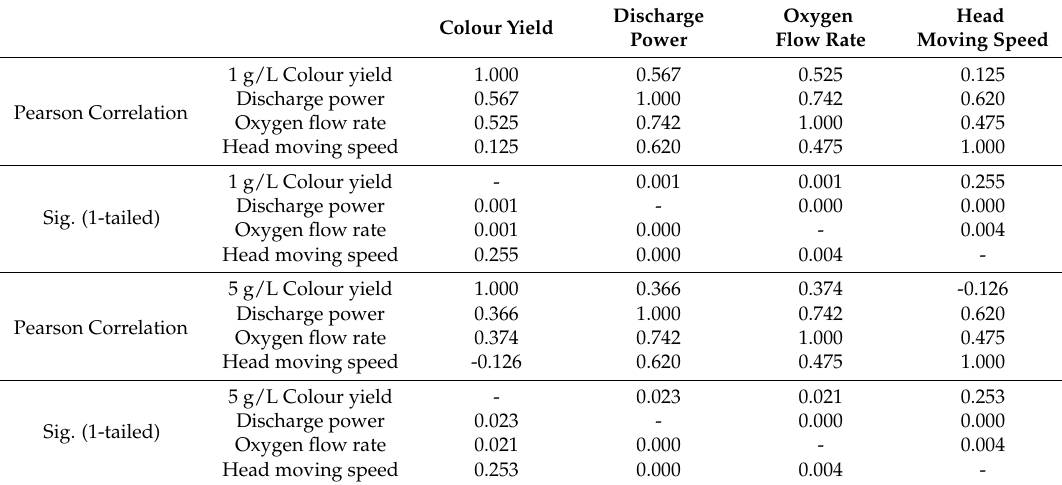
Table 7. Correlations between colour yield and atmospheric pressure plasma operation parameters.